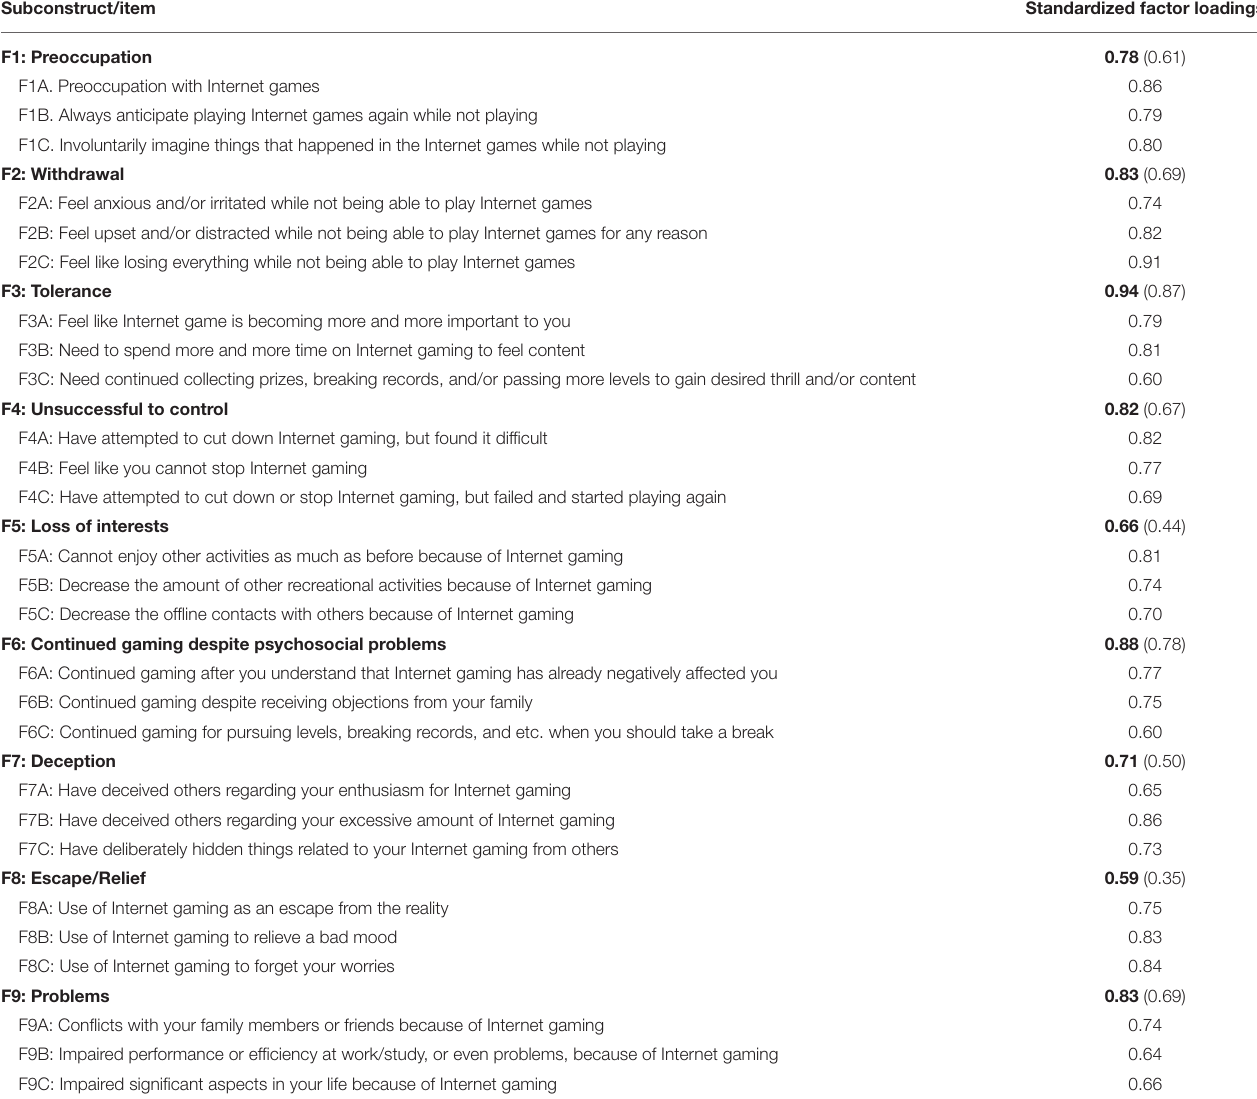
TABLE 1 | Confirmatory factor analysis results of C-IGDC among Chinese adolescents ( N = 1,253). Subconstruct/item Standardized factor